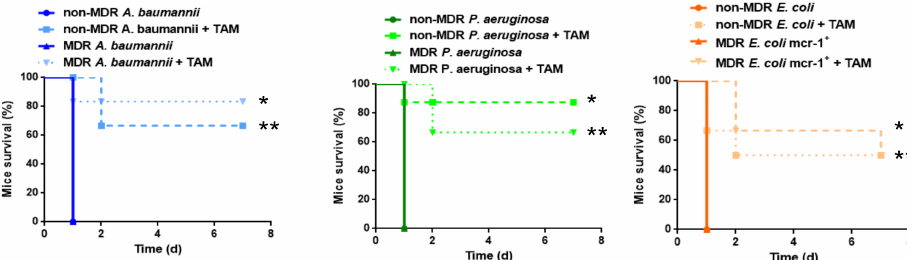
Figure 7. Tamoxifen increases the survival of mice infected with non-MDR or MDR GNB. Mice survival was monitored during 7 days for 6 mice infected with MLD100 of non-MDR and MDR A. baumannii (Ab9 and Ab186), P. aeruginosa (Pa39 and Pa238) or E. coli (C1-7-LE and EcMCR+) strains treated or not with 3 ip. doses of tamoxifen (80 mg/kg/d, for 3 days). * p < 0.05: treated vs. untreated, ** p < 0.05: treated vs. untreated, TAM: tamoxifen, MDR: